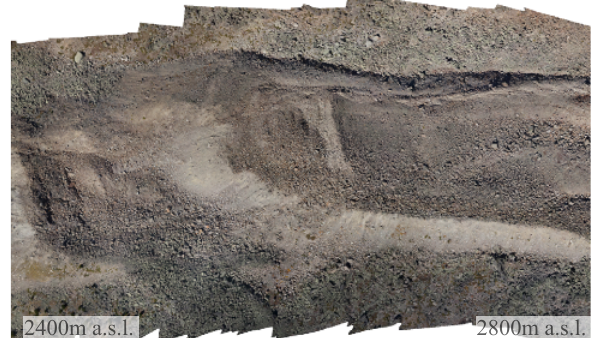
Figure 2. Orthophoto of test site Jegihorn.